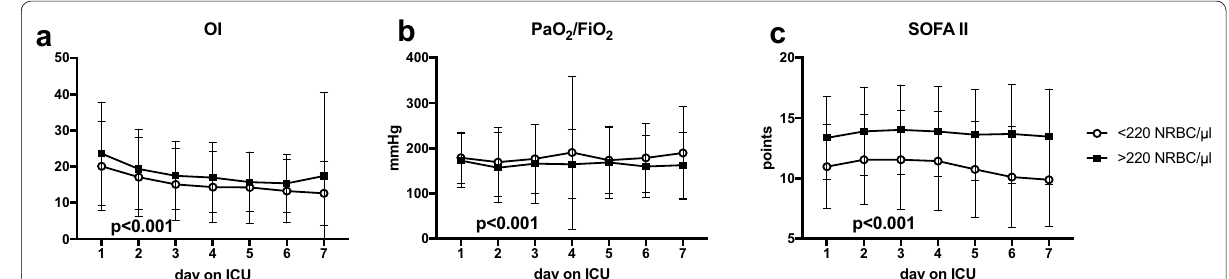
Fig. 5 a Oxygenation index (OI), b PaO 2 /FiO 2 ratio and c SOFA II score in ARDS patients grouped by the NRBC cutoff level of 220 NRBC/µl from ROC analysis in the first consecutive 7 days on the ICU. Open circles above the threshold of 220 NRBC/µl; data are presented as mean indicated p value for comparison between the two groups over time; n oxygen; OI oxygenation index, calculated as FiO 2 /PaO 2 * Pmean; Pmean mean airway pressure; SOFA Sequential Organ Failure Assessment; ICU intensive care unit; NRBC nucleated red blood